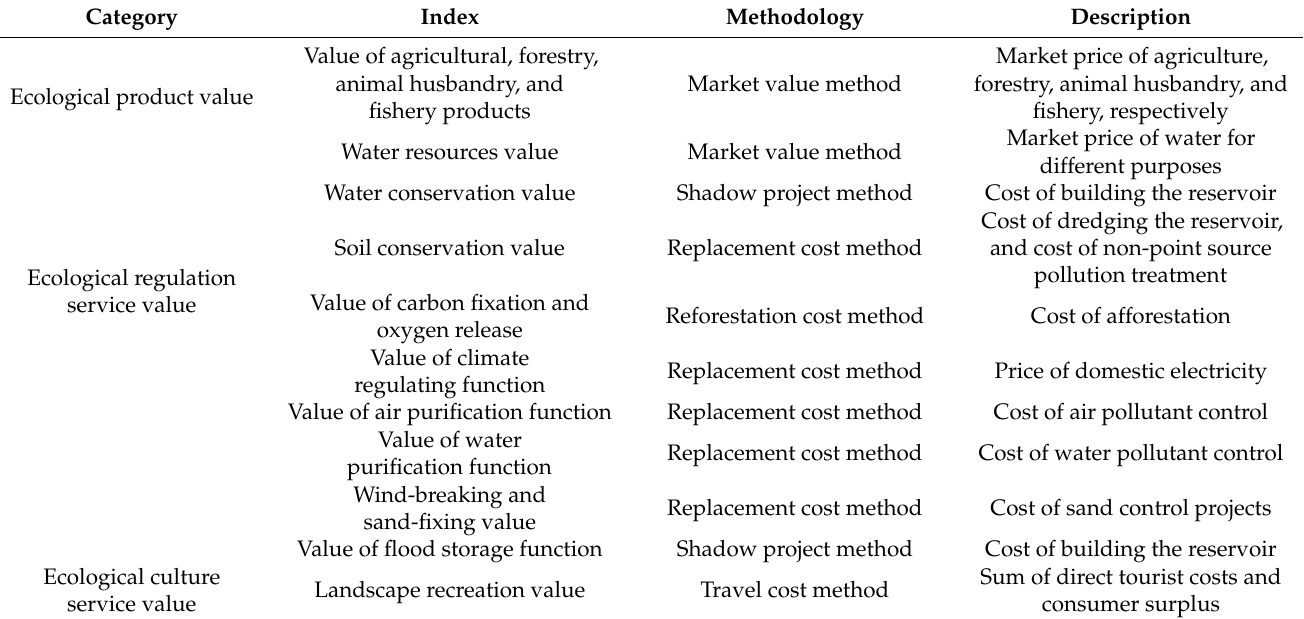
Table 1. Evaluation method for ecosystem service